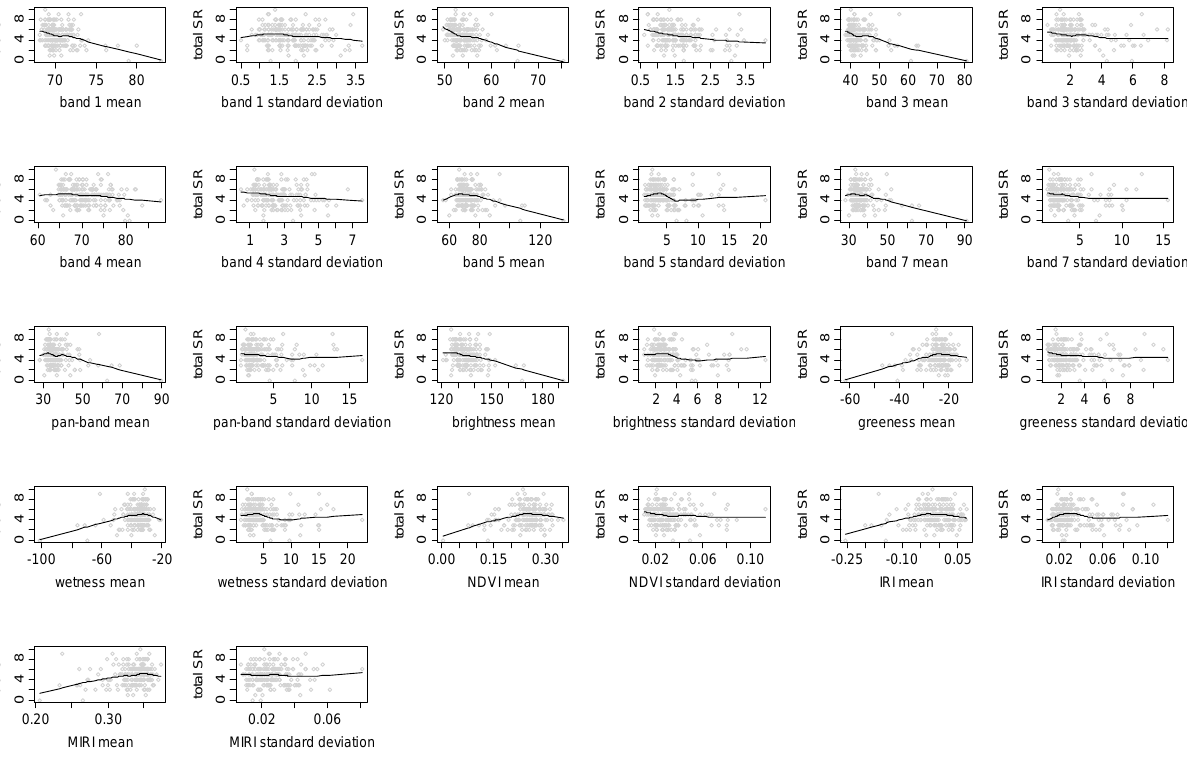
Figure 3. Scatterplots of tree species richness (SR) vs. Landsat ETM+ spectral variables. Fitted curves represent LOWESS based